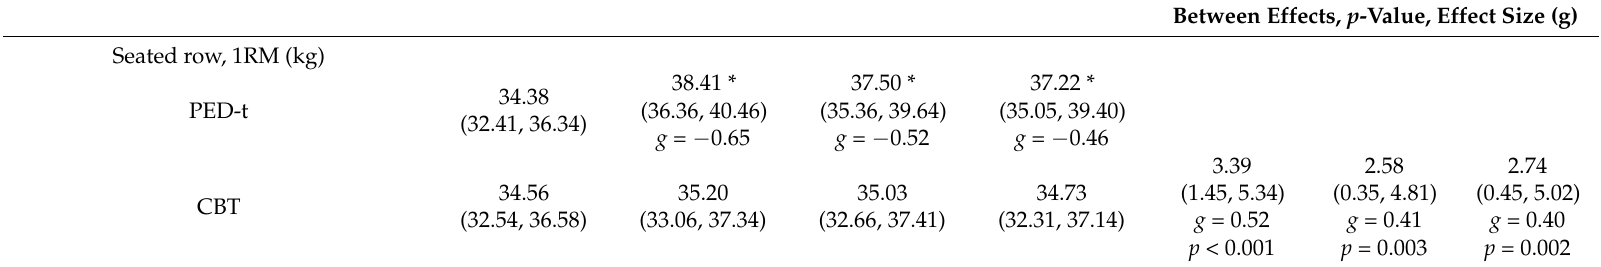
Between Effects, p -Value, Effect Size